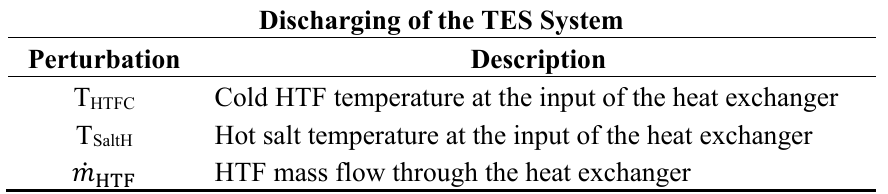
Table 7. TES discharging